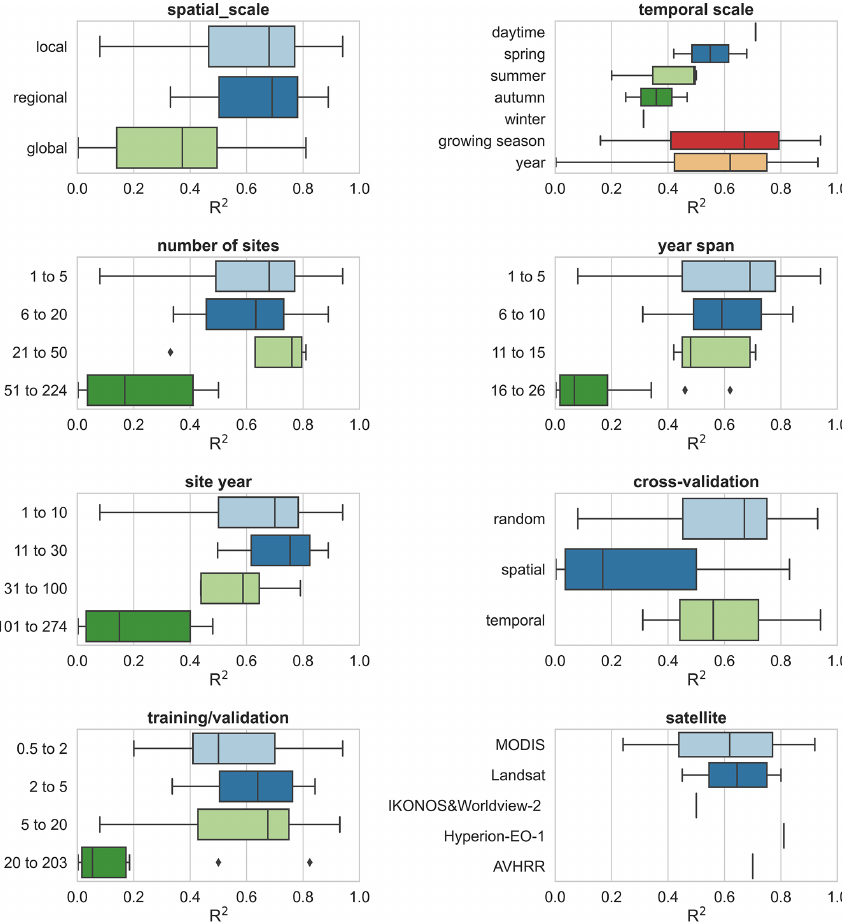
Figure 8. The impacts of other features (i.e., spatial scale, study period, number of sites, year span, site year, cross-validation method, training / validation, and satellite imagery) on the model